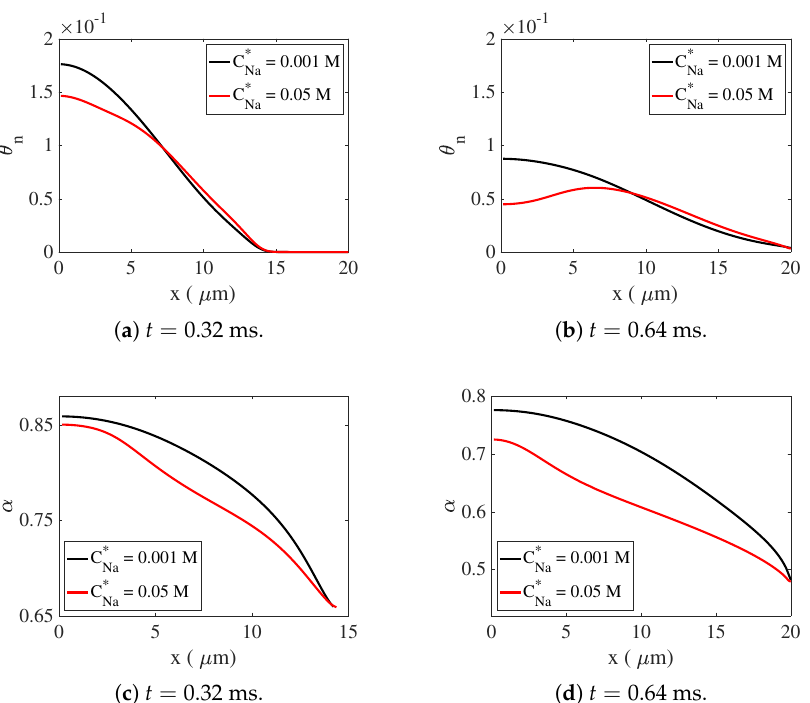
= 0.001 M and 0.05 M. Distributions Na